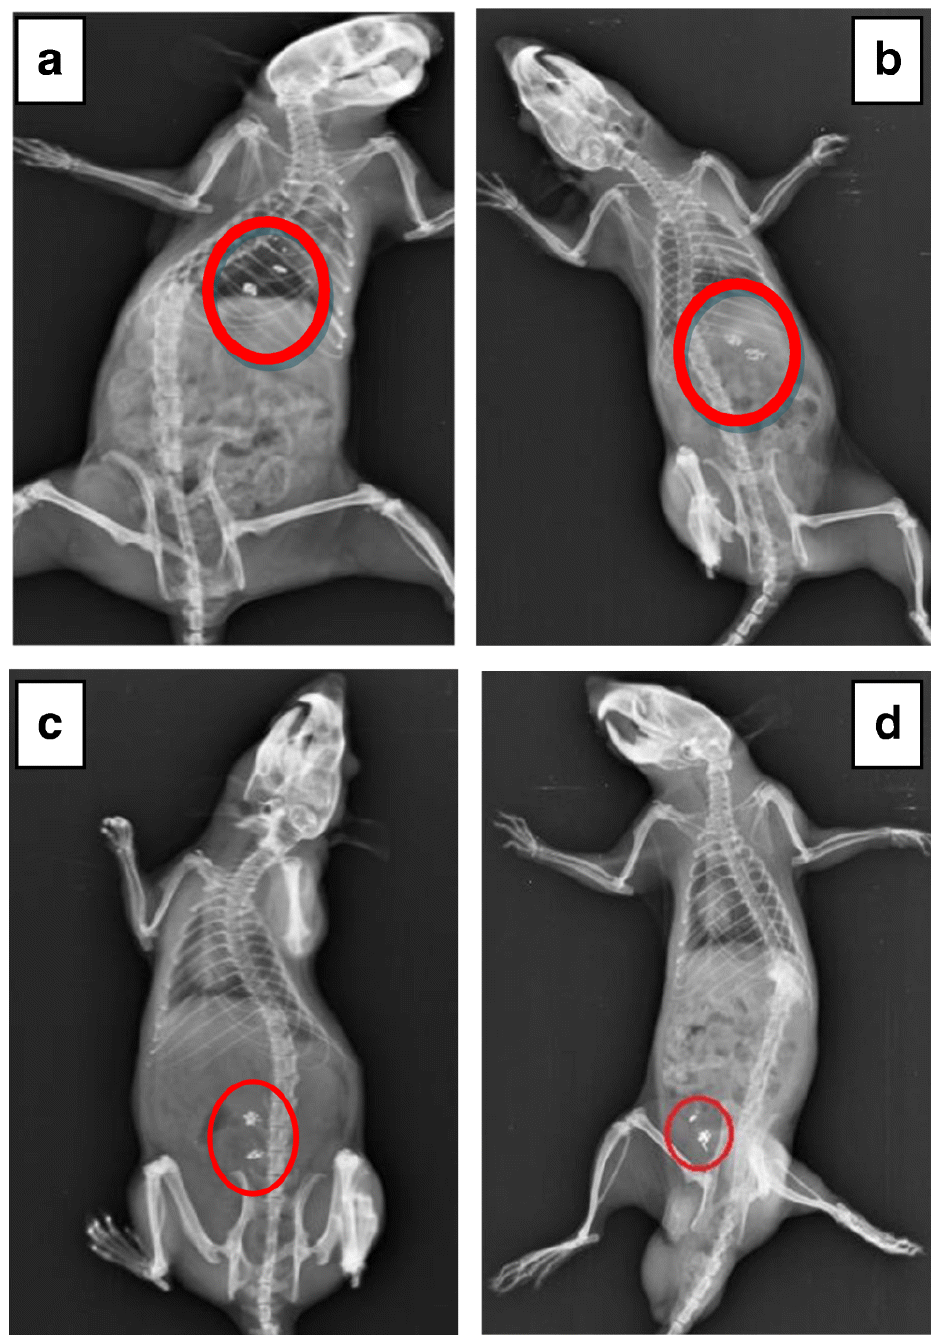
Figure 7. X-ray images of rats treated with barium sulfate-loaded microparticles obtained after ( a ) 2, ( b ) 4, ( c ) 6, and ( d ) 6 h. The red circles indicate the presence of BaSO 4 -loaded microparticles. Reproduced from [75] with permission.